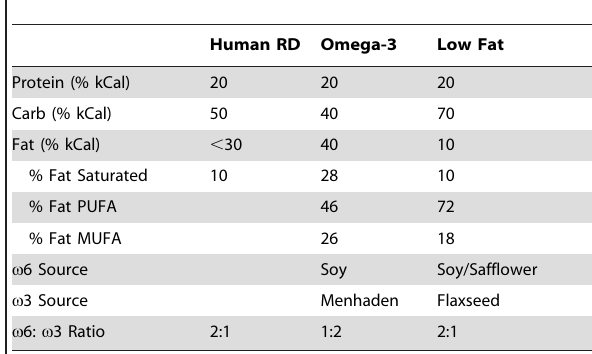
Table 1. Fatty acid content and source for the diets